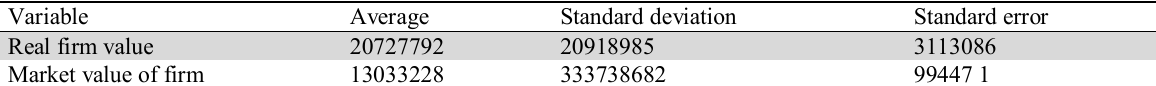
Statistical indicators of the real and market values Variable Average Standard deviation